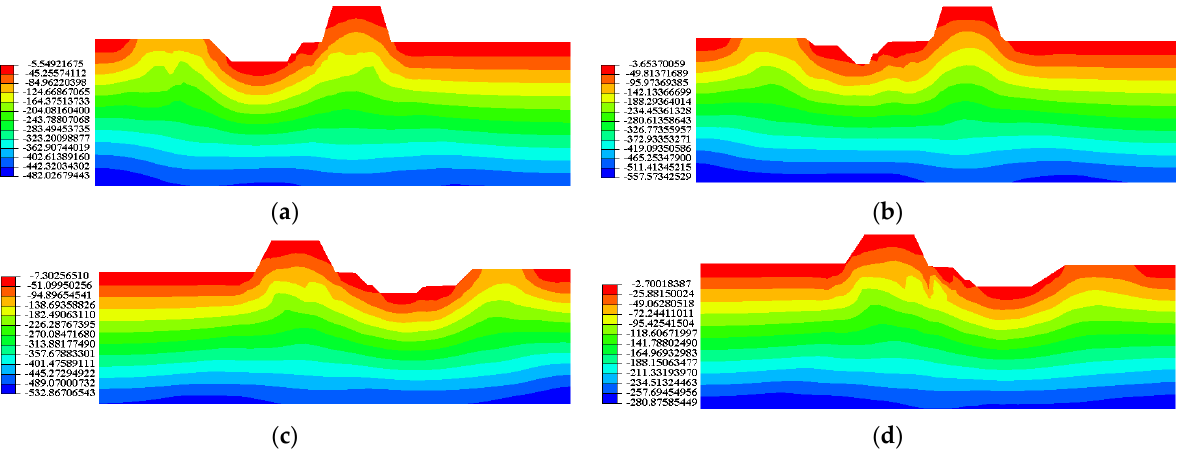
Figure 12. Diagram of the simulation results of longitudinal stress of dangerous sections under con-